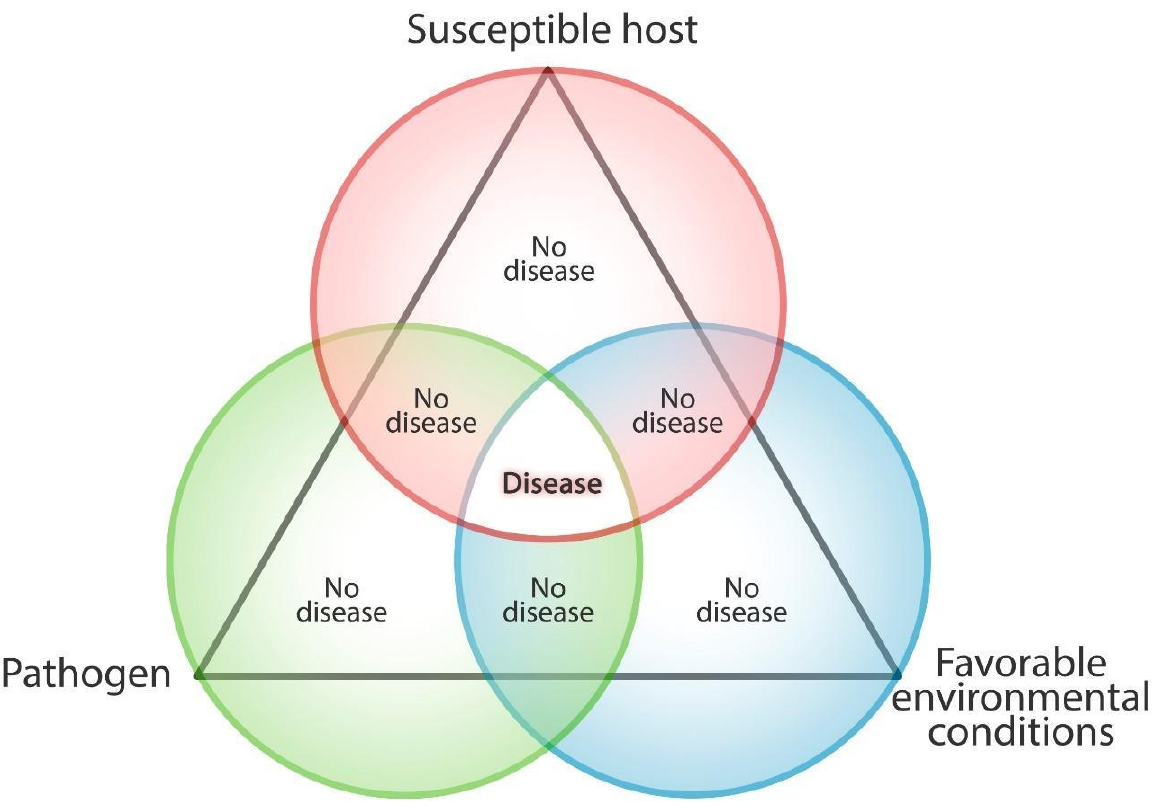
Figure 1. Disease triangle showing the interactions needed for the development of biotic stress in in plants.